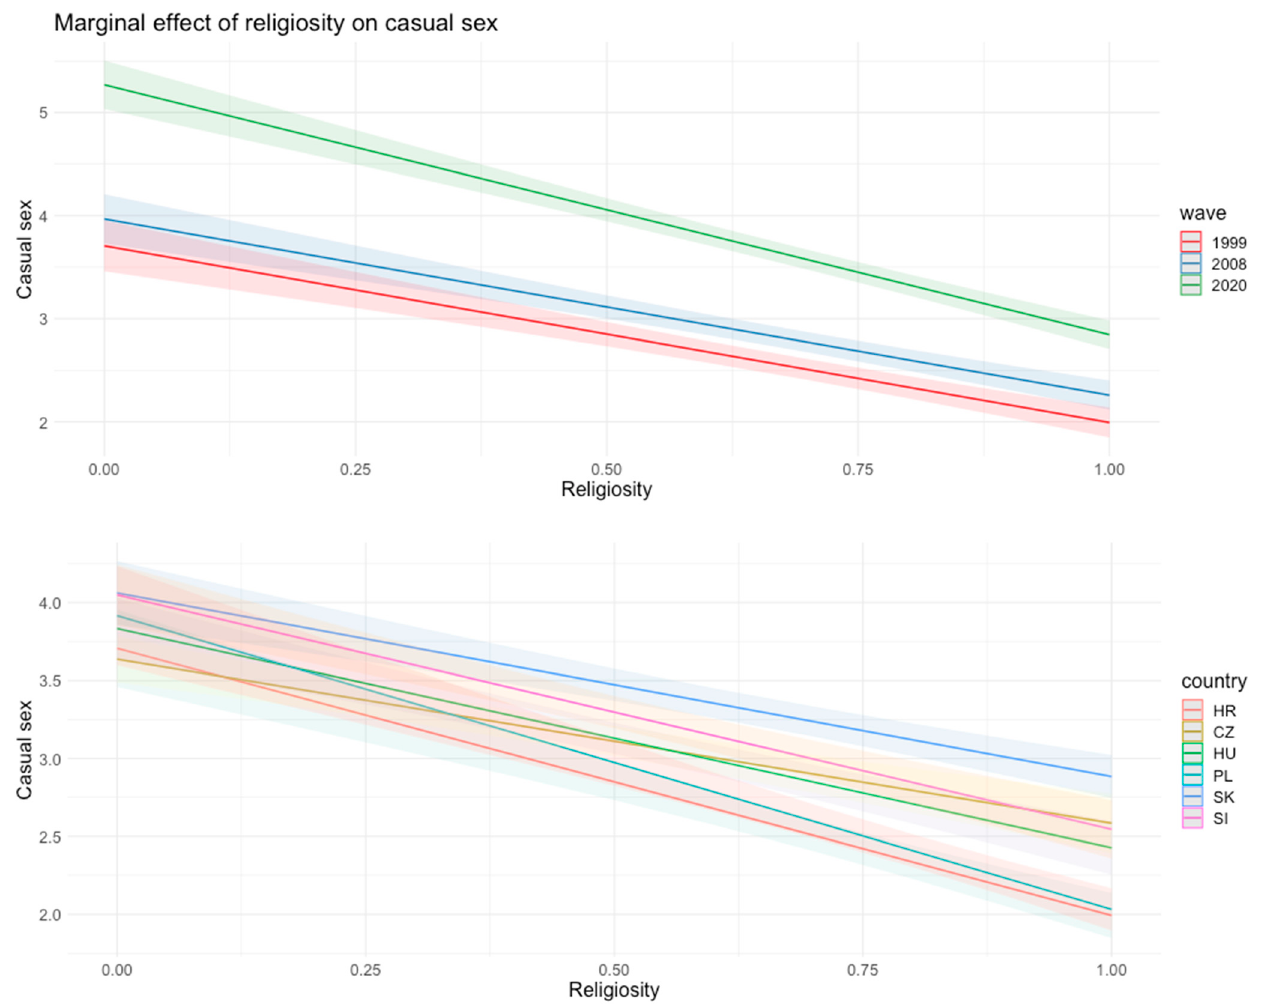
Figure 3. Average Marginal Effect of religiosity per country and year casual sex. A more detailed regression table with the interaction effects is available in the Supplementary Materials.